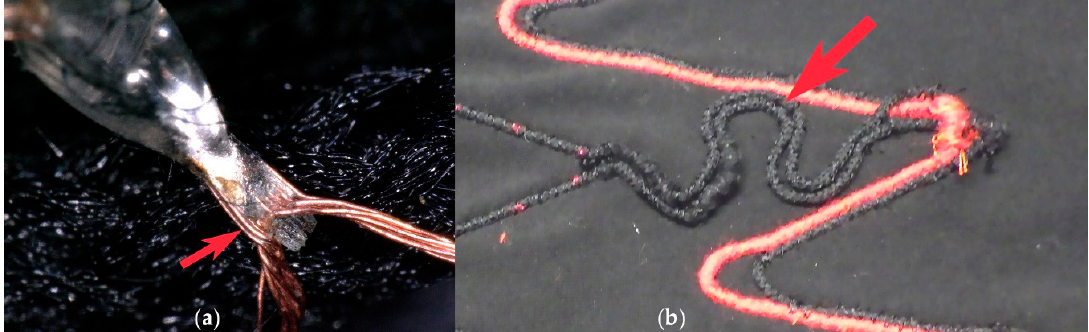
Figure 9. Breakage analysis of the E-yarns. ( a ) Connection between two copper wires magnified 100 times. The arrow indicates an area that is not covered by resin. ( b ) The arrow indicates a zig-zag connection between black LED-yarn and red E-yarn. This was added to reduce further breakages.